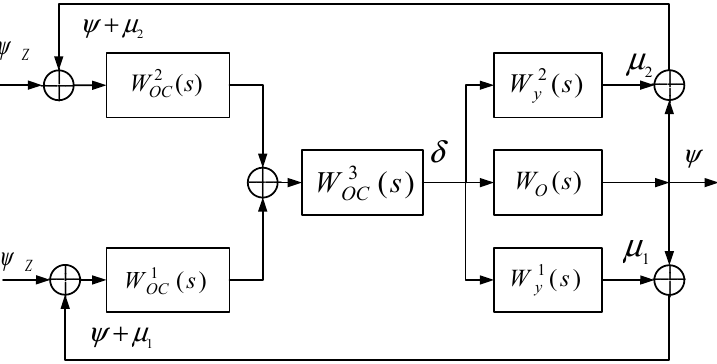
Figure 8. Block diagram of the stabilization system with two gyroscopic devices.